Question: Describe this figure in one sentence.
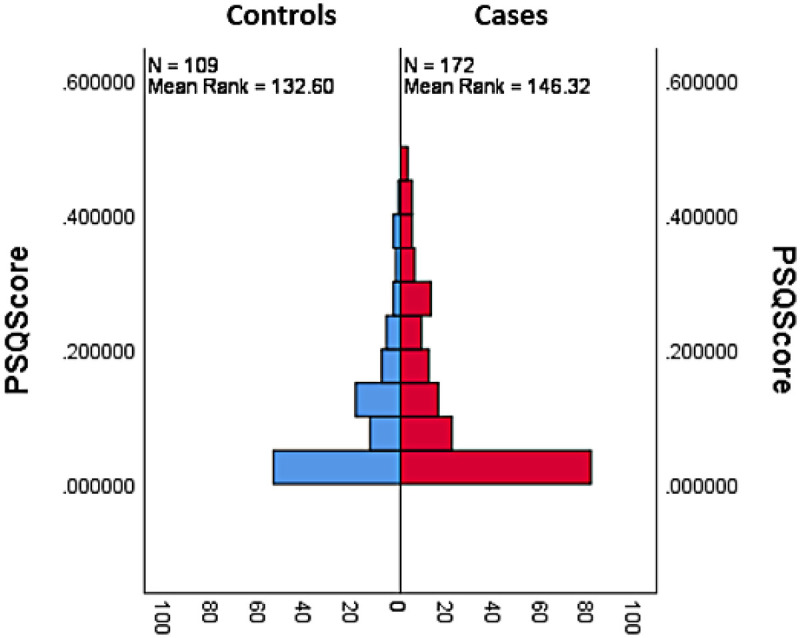
Answer: Display of the difference between cases and controls in terms of the variation of the PSQ score across the study sample, according to the U Mann–Whitney test.